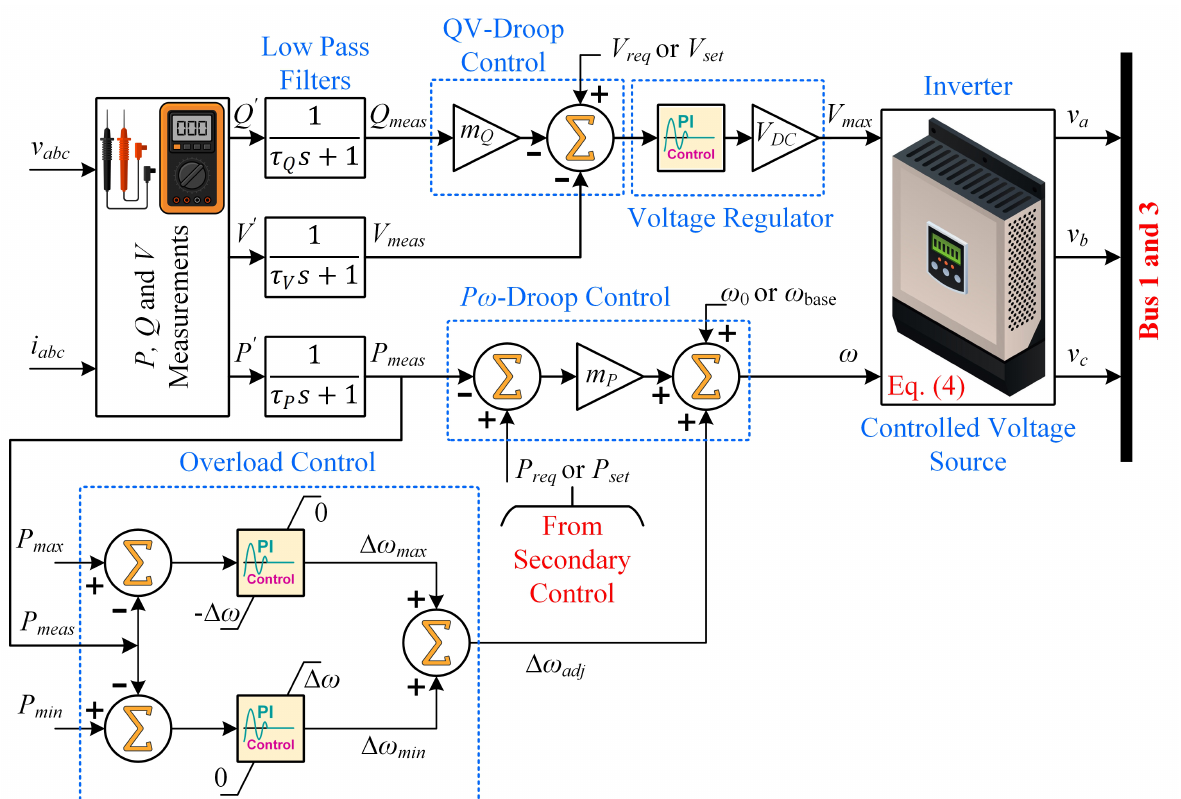
Figure 3. Droop/primary control and overload control for inverter-based